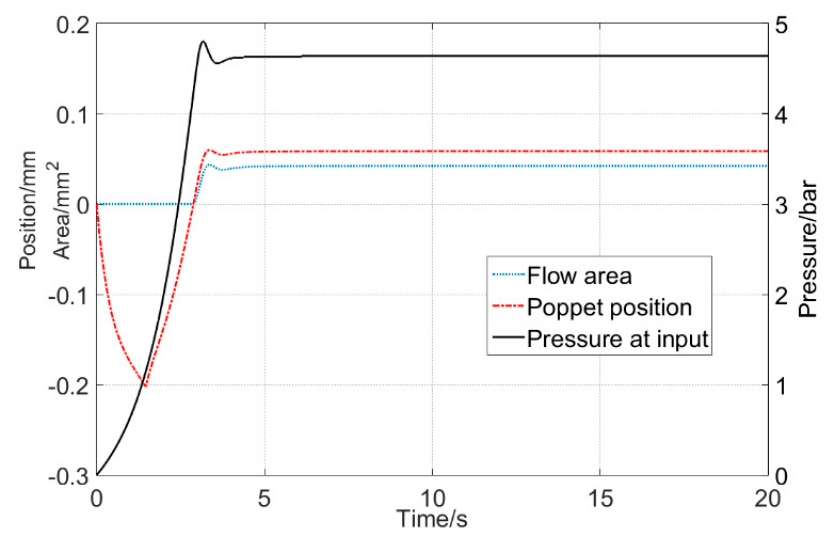
Figure 20. The poppet position, the flow area, and the pressure at the input of the hydraulic lock. In the beginning, the poppet position changed to − 0.2 mm, which was because of the spool displacement caused by the spring preload. With the increase of input pressure, the pressure generated by P inA overcame the spring preload. When the valve poppet position was greater than 0, the valve